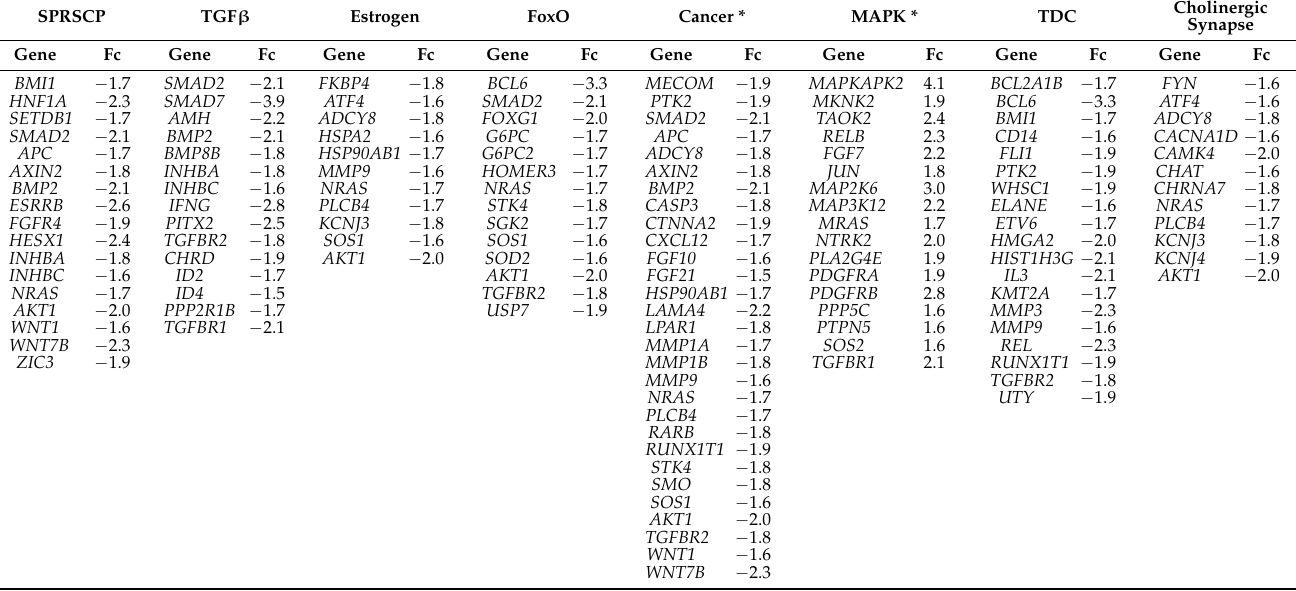
Table 6. Changes in gene expression of dogs fed with polyherbal vs. choline chloride in biological processes related to